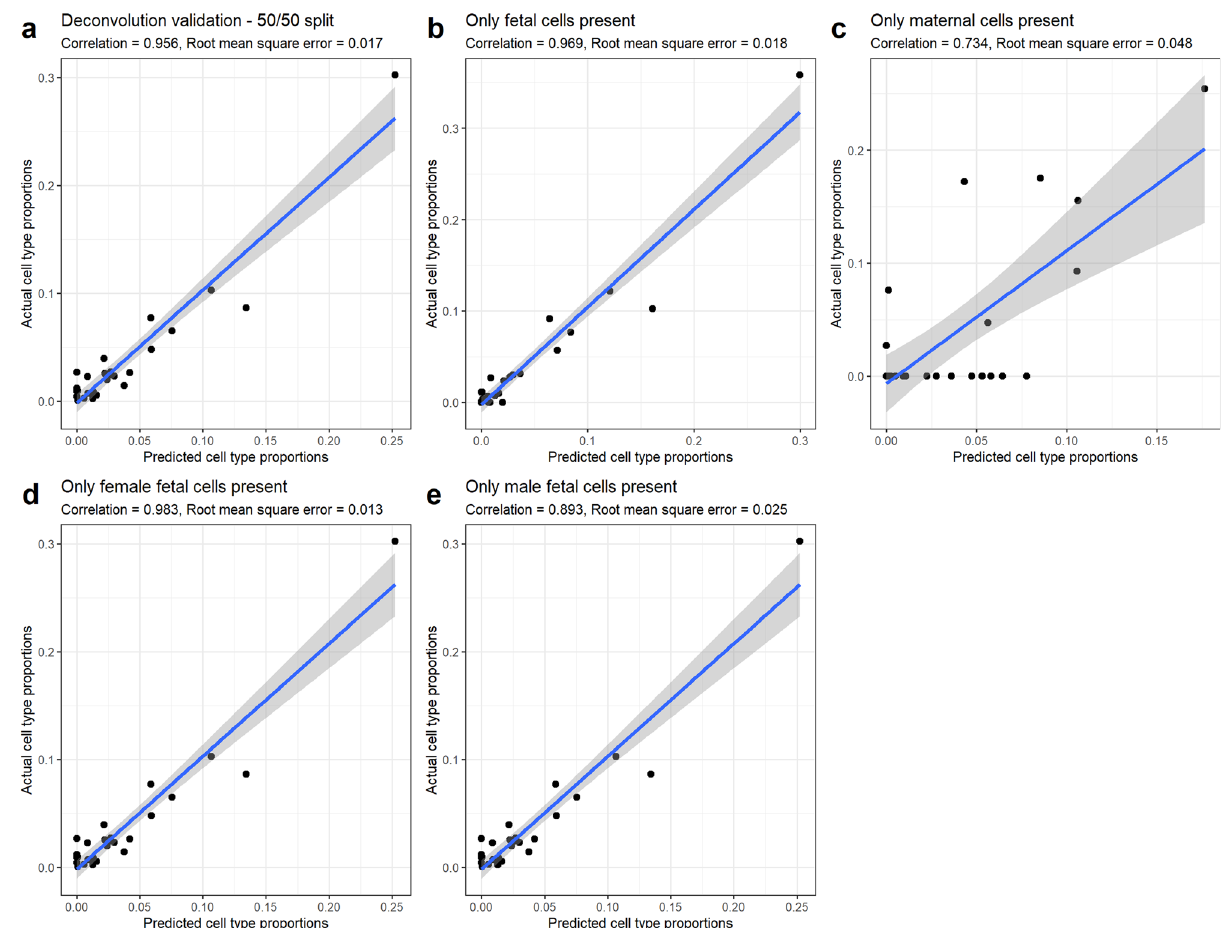
Fig. 2 In silico placental deconvolution testing. Scatter plots summarizing the performance of our single-cell deconvolution reference using CIBERSORTx with in silico mixtures of single-cell libraries from a 50/50 training/test split of the integrated single-cell RNA-seq dataset ( n = 40,494). The same training dataset was used for each comparison; test mixtures were generated from the testing half of the dataset. Predicted deconvoluted cell type proportions for each of the 27 cell types are encoded on the x-axis. Actual cell type proportions from the test dataset are encoded on the y-axis. Correlation coef fi cients and root mean square error measures are presented for each comparison. A linear line of best fi t overlays the results. The gray shaded area represents the 95% con fi dence intervals around the simple linear regression estimates. a The test mixture is the test half of the single-cell dataset ( n = 20,242). b The test mixture sampled only fetal cells ( n = 17,080). c The test mixture sampled only maternal cells ( n = 3162). d The test mixture sampled only female fetal cells ( n = 8394). e The test mixture sampled only male fetal cells ( n =